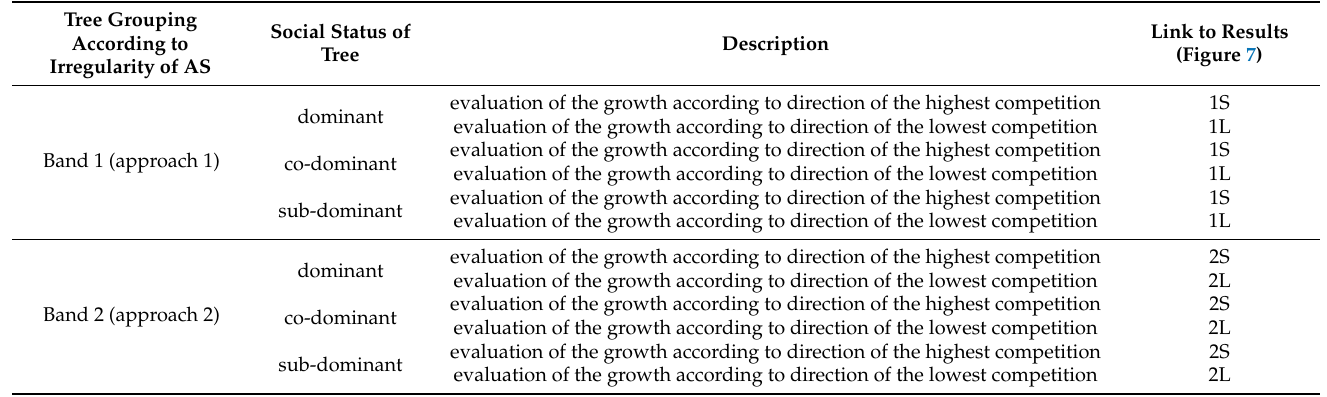
Table A1. Summary of data evaluation